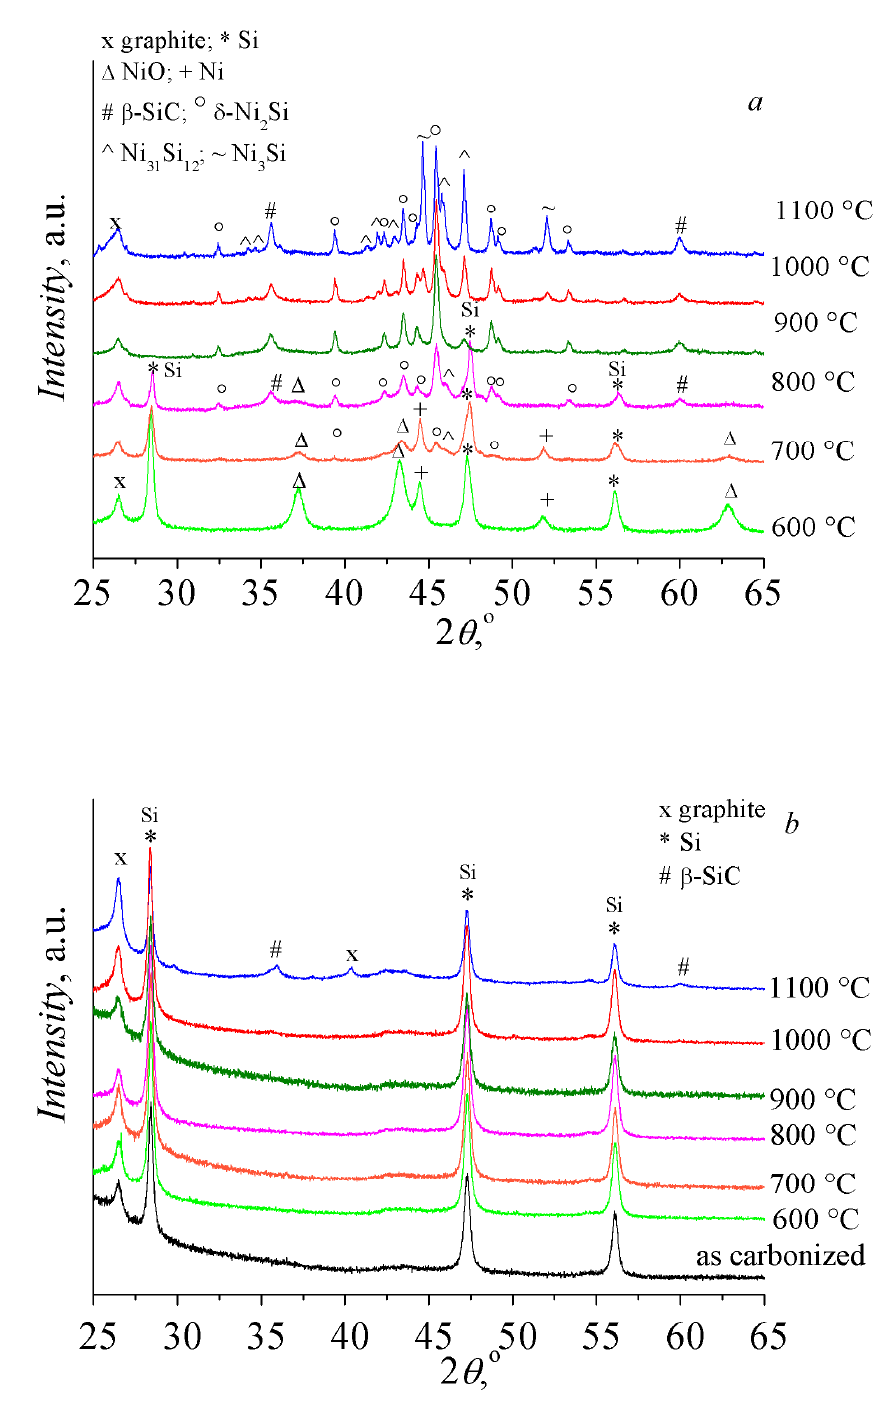
Figure 3. XRD patterns of samples annealed at different temperatures: ( a ) composites with Ni, ( b ) control without Ni.